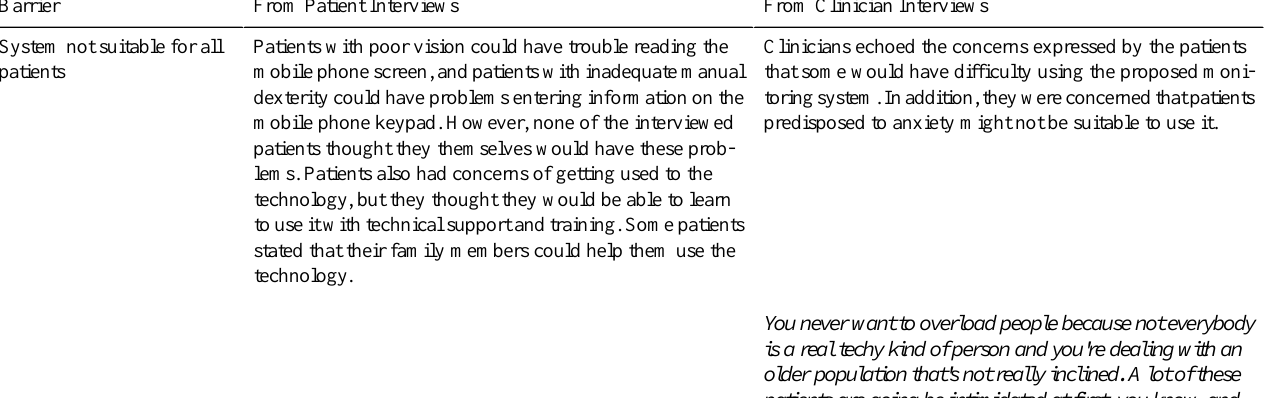
From Clinician InterviewsFrom Patient InterviewsBarrier Clinicians echoed the concerns expressed by the